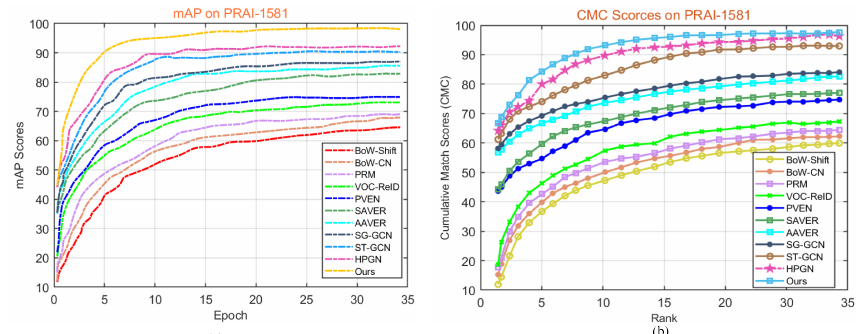
Figure 7. The mAP and CMC curve comparison of our method and several state-of-the-art approaches on PRAI-1581 dataset. ( a ) mAP curve comparison on the PRAI-1581; ( b ) CMC curve comparison on the